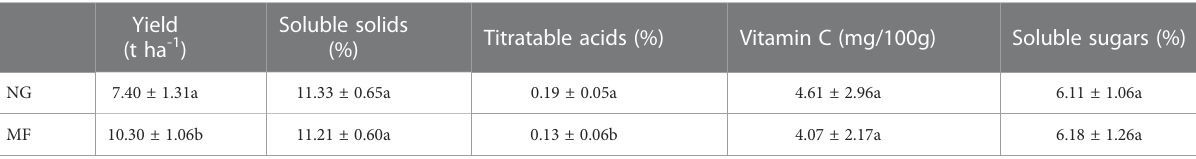
Valuesare mean ±standard deviation from 5replicates. Lowercase lettersaandb indicate asigni fi cant difference(p< 0.05).NG, naturalgrass;T, planting ryegrassandmowing